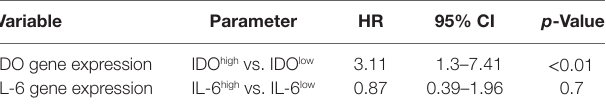
TaBle 5 | Distribution of clinical–pathological characteristics, in cancer sorted according to indoleamine 2,3-dioxygenase (IDO) or interleukin (IL)-6 gene